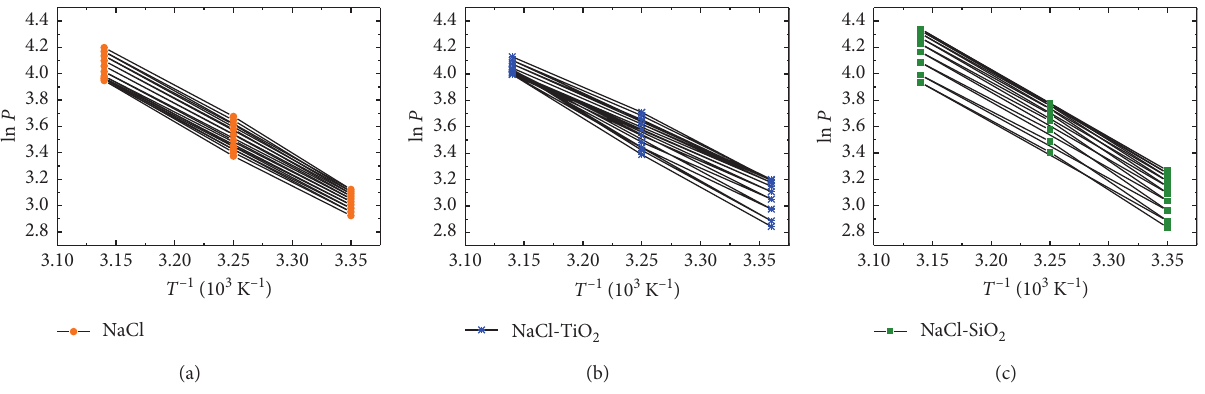
Figure 13: Variation of ln ( P ) vs. ( T − 1 ) of (a) NaCl, (b) NaCl-TiO